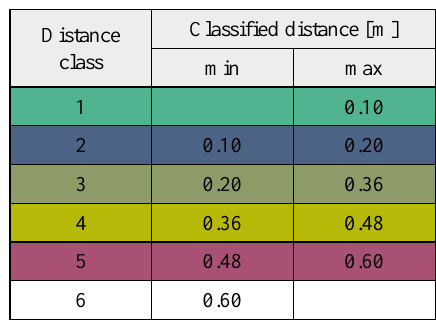
Figure 12. Map of distances